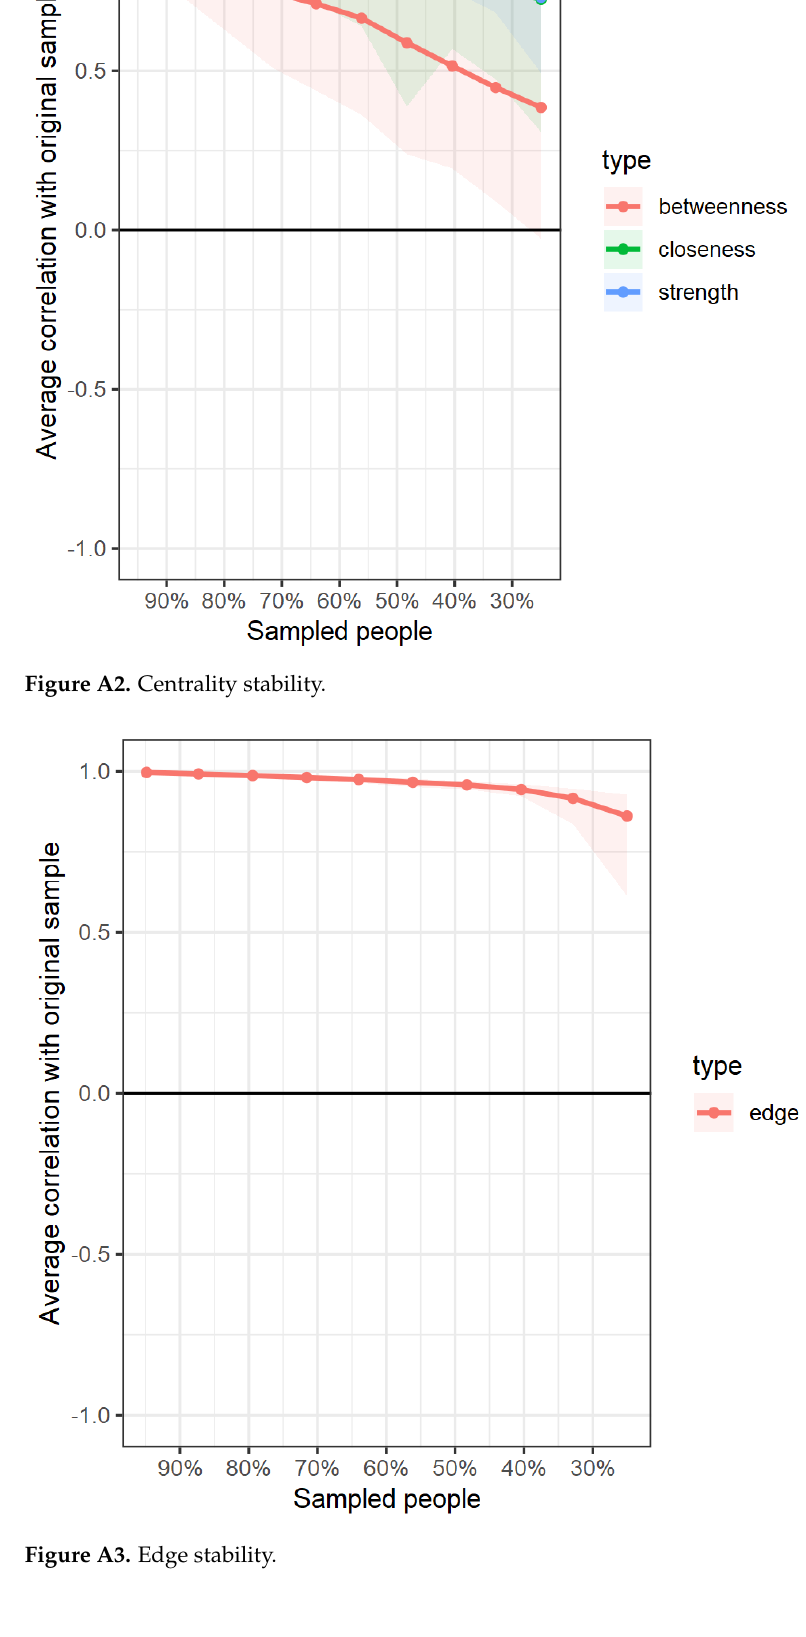
Figure A3. Edge Figure A3. Edge stability.